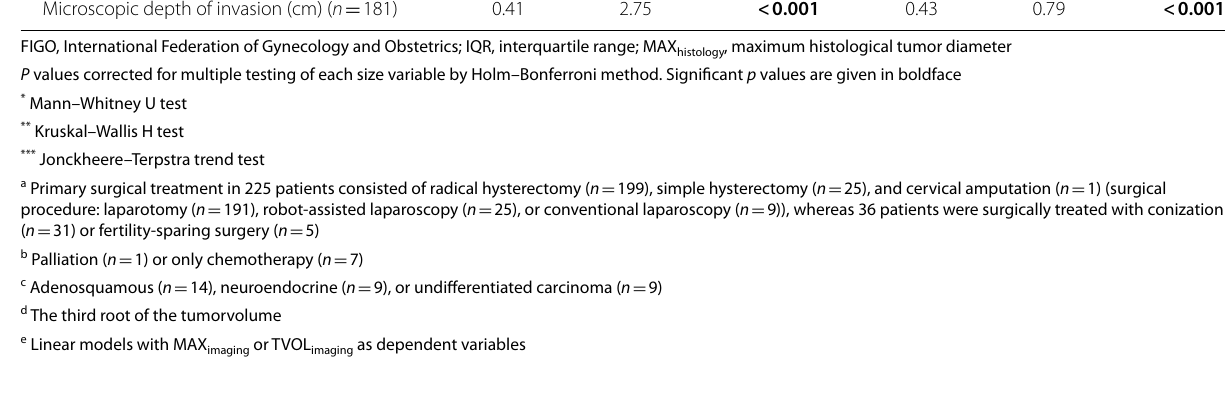
FIGO, International Federation of Gynecology and Obstetrics; IQR, interquartile range; MAX histology , maximum histological tumor diameter P values corrected for multiple testing of each size variable by Holm–Bonferroni method. Significant p values are given in boldface